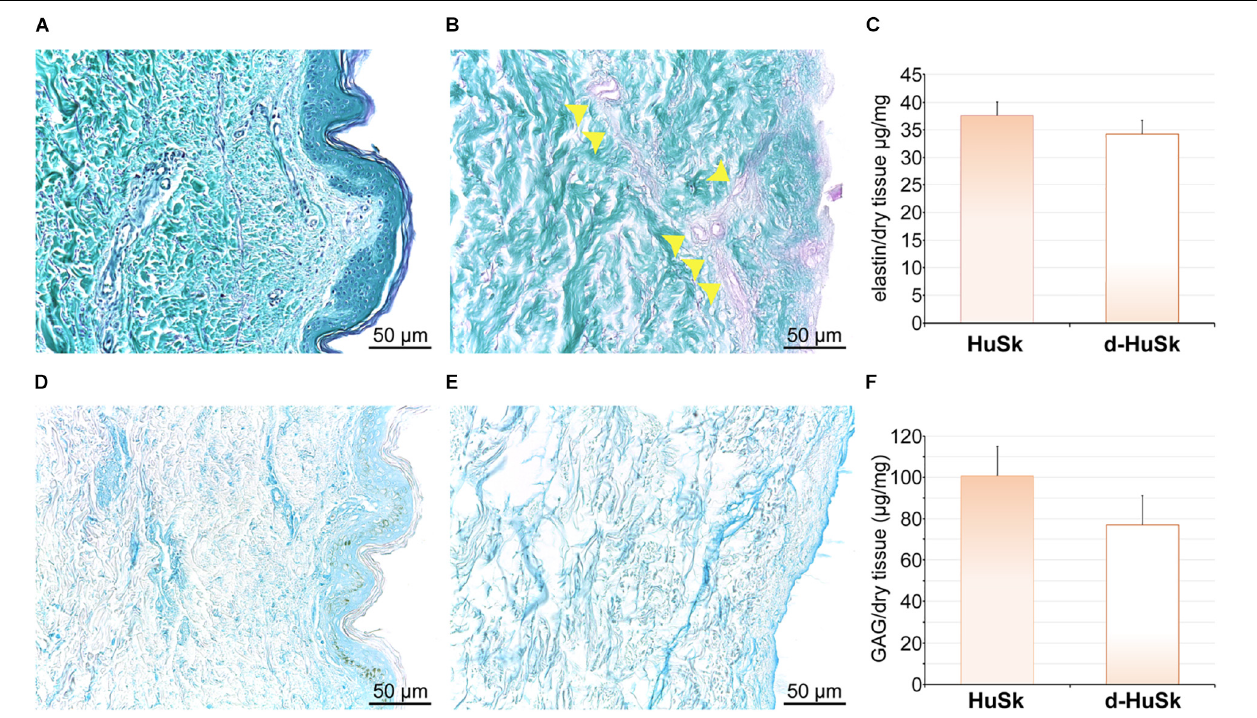
FIGURE 2 | Histochemical and quantitative analysis of elastin and GAG content in native human skin (HuSk) and in d-HuSk. Representative images of the histochemical analysis performed by Paraldehyde fuchsin Gomori staining showing the presence of elastic fibers in HuSk (A) and d-HuSk (B) . Patent blood vessels surrounded by abundant elastic fibers are apparent in d-HuSk (yellow arrowheads). (C) Quantification of elastin by specific dye-binding assay showing comparable content of elastin in d-HuSk and HuSk. Representative images of the histochemical analysis performed by Alcian Blue staining and showing by the light blue color the presence of GAGs in HuSk (D) and d-HuSk (E) . (F) Quantification of GAGs by specific dye-binding assay showing no statistically significant difference in content of GAGs in d-HuSk and HuSk. Scale bar is 50 µ